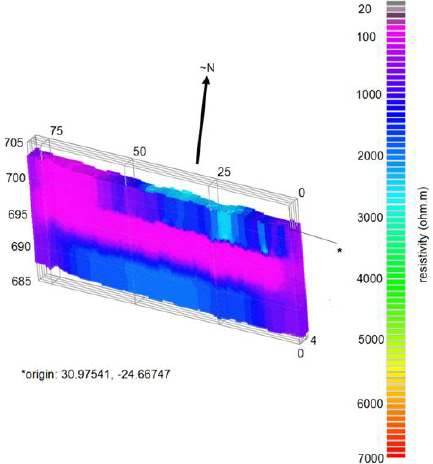
Fig. 12. Pseudo 3-D resistivity section of the SW-NE parallel tran- sects. Scales are in metres diverging from a geographical origin, vertical scale is altitude a.s.l. (Wenner long, 2m spacing, 6th itera- tion, RMS error 5.92%).